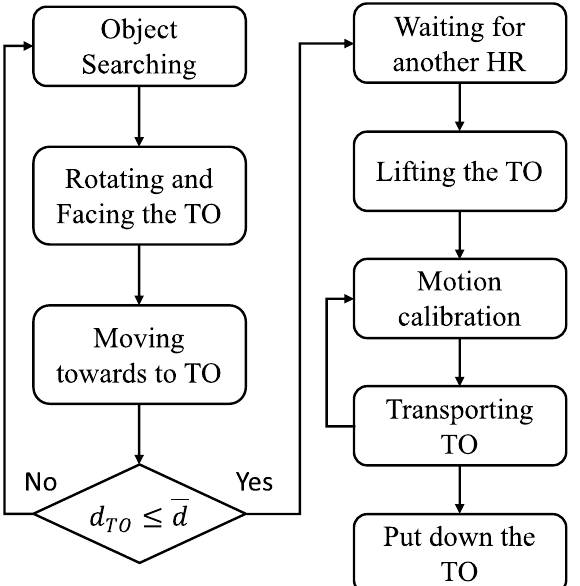
Figure 4. Flowchart of the motion of HR.